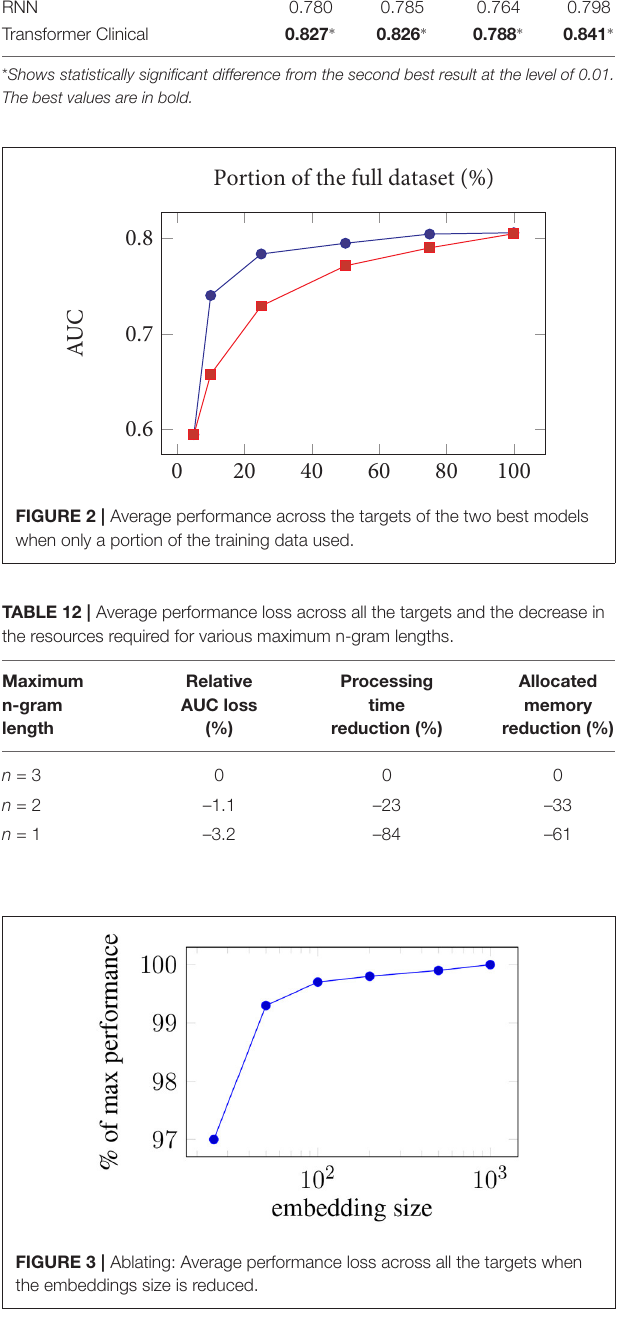
at deeper layer, e.g., using non-text attributes as input to the transformer’s attention computation. Long term contextual information along the lines of scalable transformers [e.g., (18,